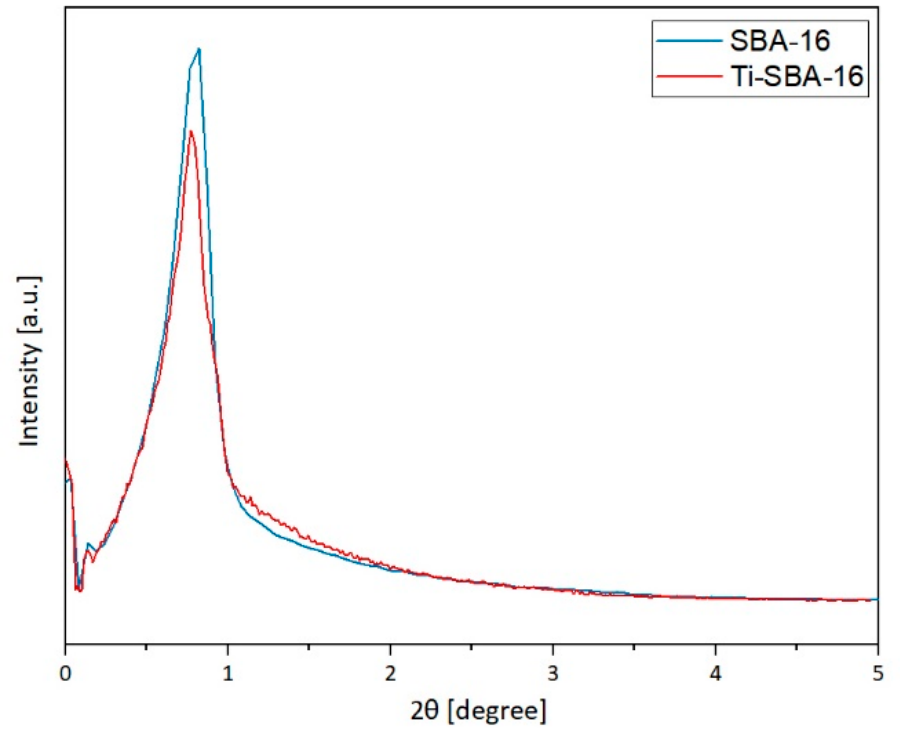
Figure 5. Diameter at the entrance to the cage distribution calculated by the BJH method from the desorption branch for the SBA-16 and Ti-SBA-16.